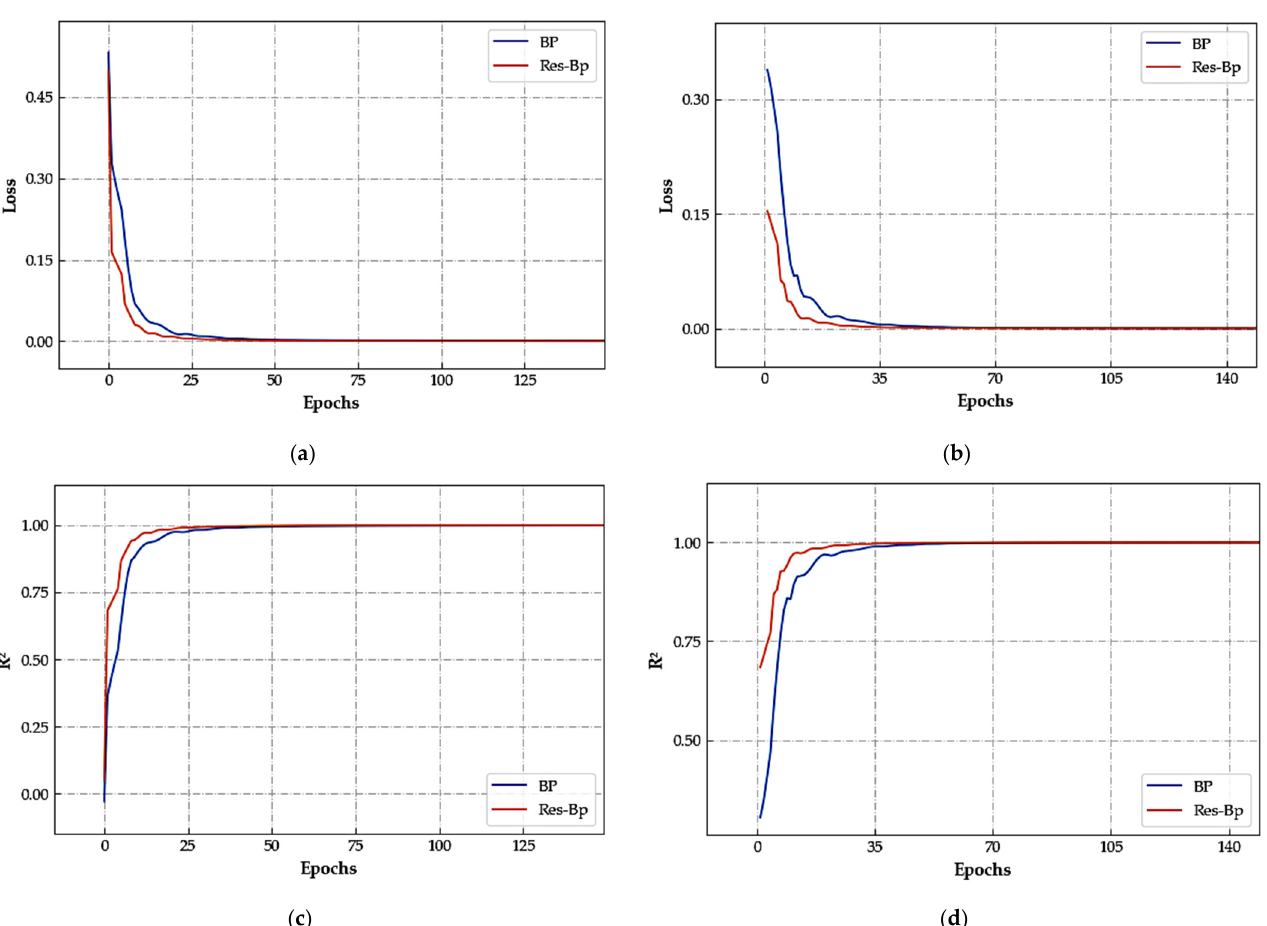
Figure 9. The gradient value of the same parameter during Res-Bp and BP training.